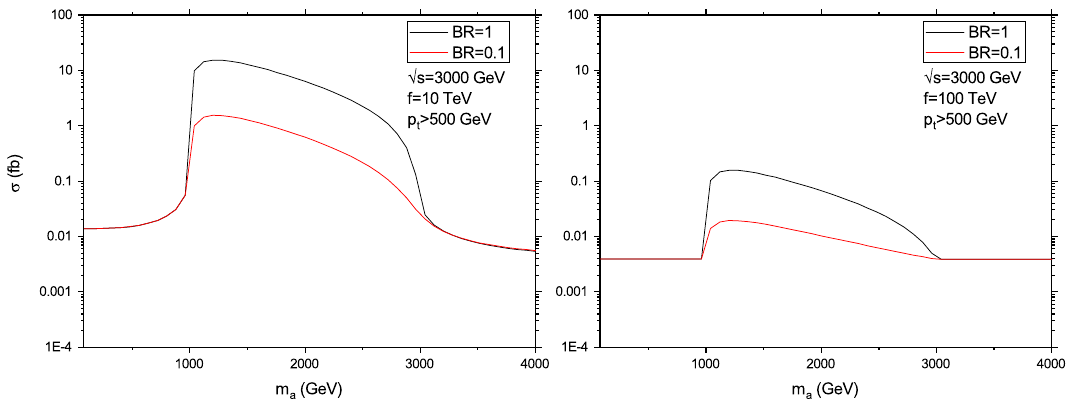
Figure 11 . The total cross sections for the process e + e − CLIC in the WWA for the initial photons as functions of the ALP mass m a for f = 10 TeV and f = 100 TeV with two values of Br( a